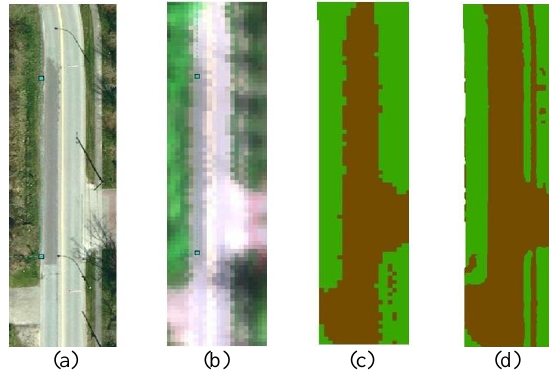
Figure6. Integrated LiDAR method toimprove road and sidewalk section using orthophotographs-10cmresolution (a), hyperspectral imagery-1m resolution (b), initial classification (c), and refined classification (d)